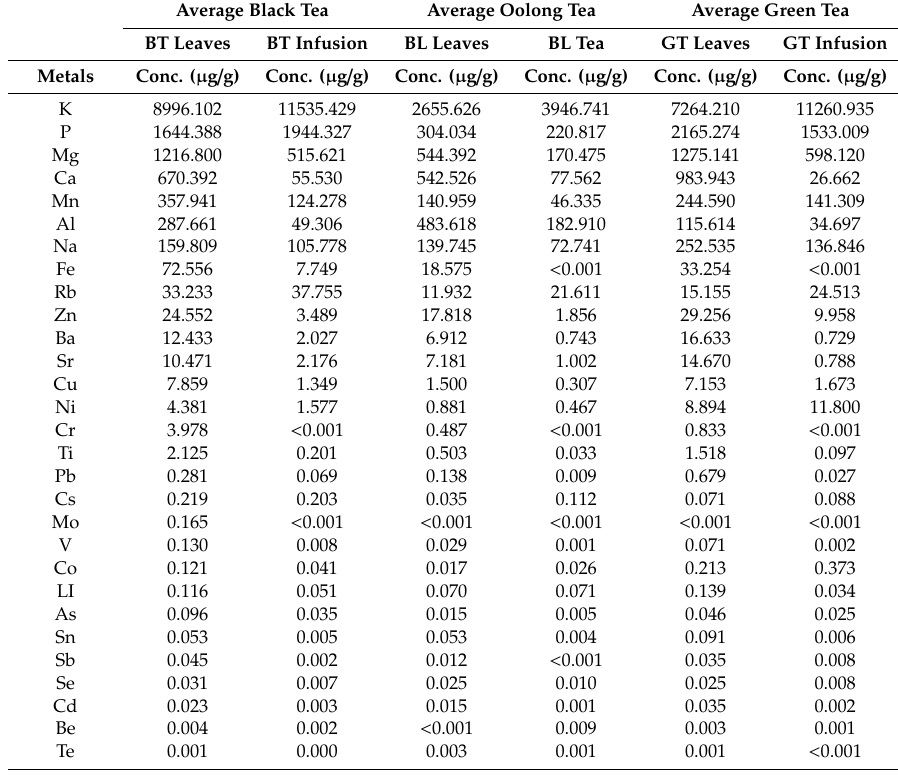
Table 2. Metals quantification in leaves and infusion of three tea di ff erently fermented (black tea = BT; blue tea = BL; green tea = GT). The average values were calculated for each tea type.